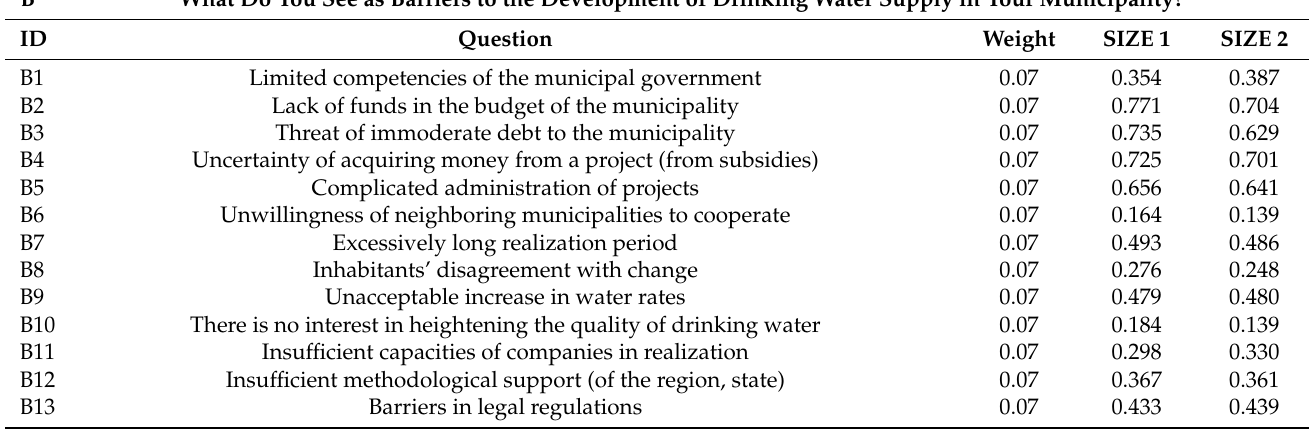
Table 8. Sub-questions of the Barrier Indicator: weights and average